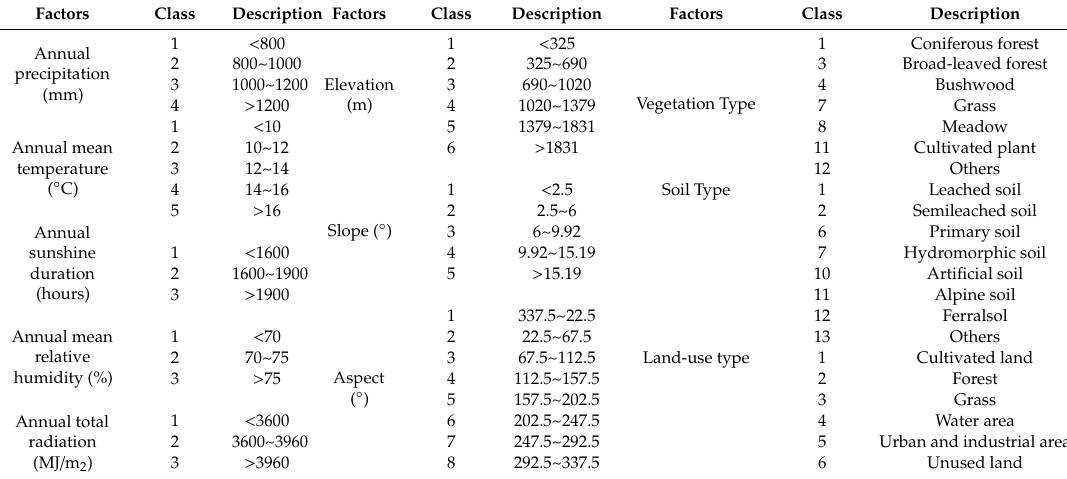
Table 2. The classification of